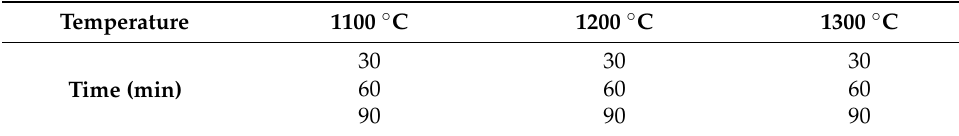
Table 4. Experimental test plan.